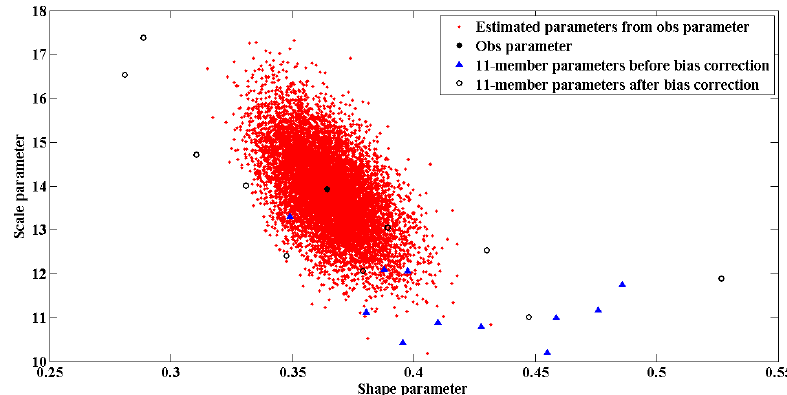
Figure 13. Result of using one transfer function for bias correction.